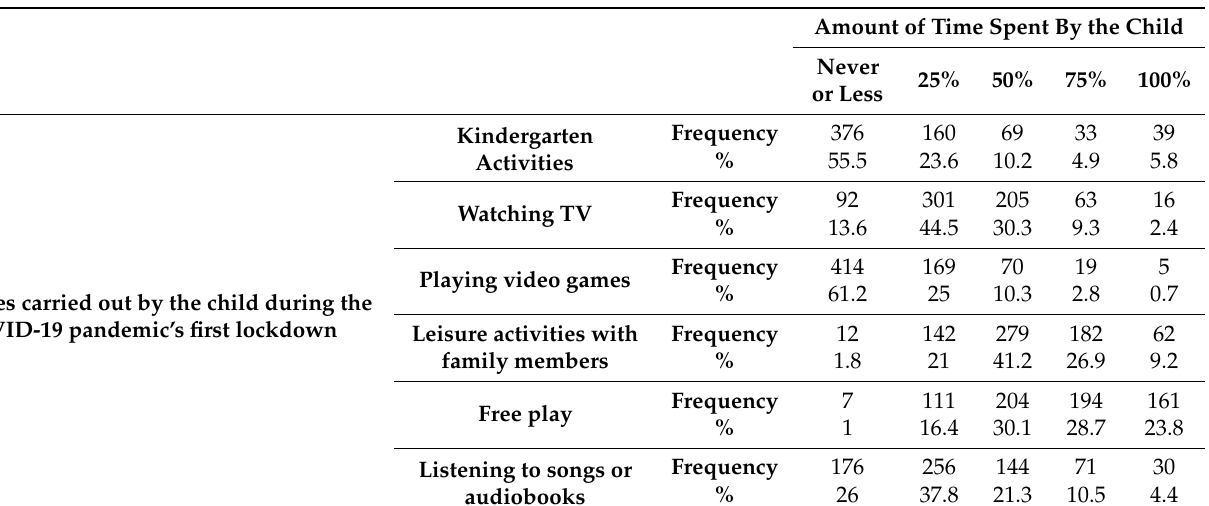
Table 2. Descriptive statistics of activities carried out by the child during the COVID-19 pandemic’s first lockdown in the total sample ( n =